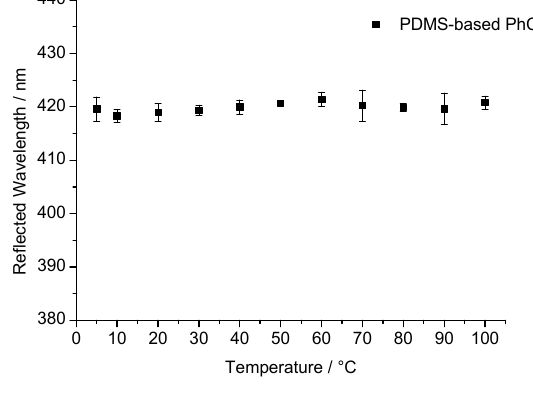
Figure 6. Effect of temperature on the peak wavelength of reflected light of the PDMS-based photonic crystal sensor, showing that it virtually has no effect. Data were acquired with a sensor film exposed to